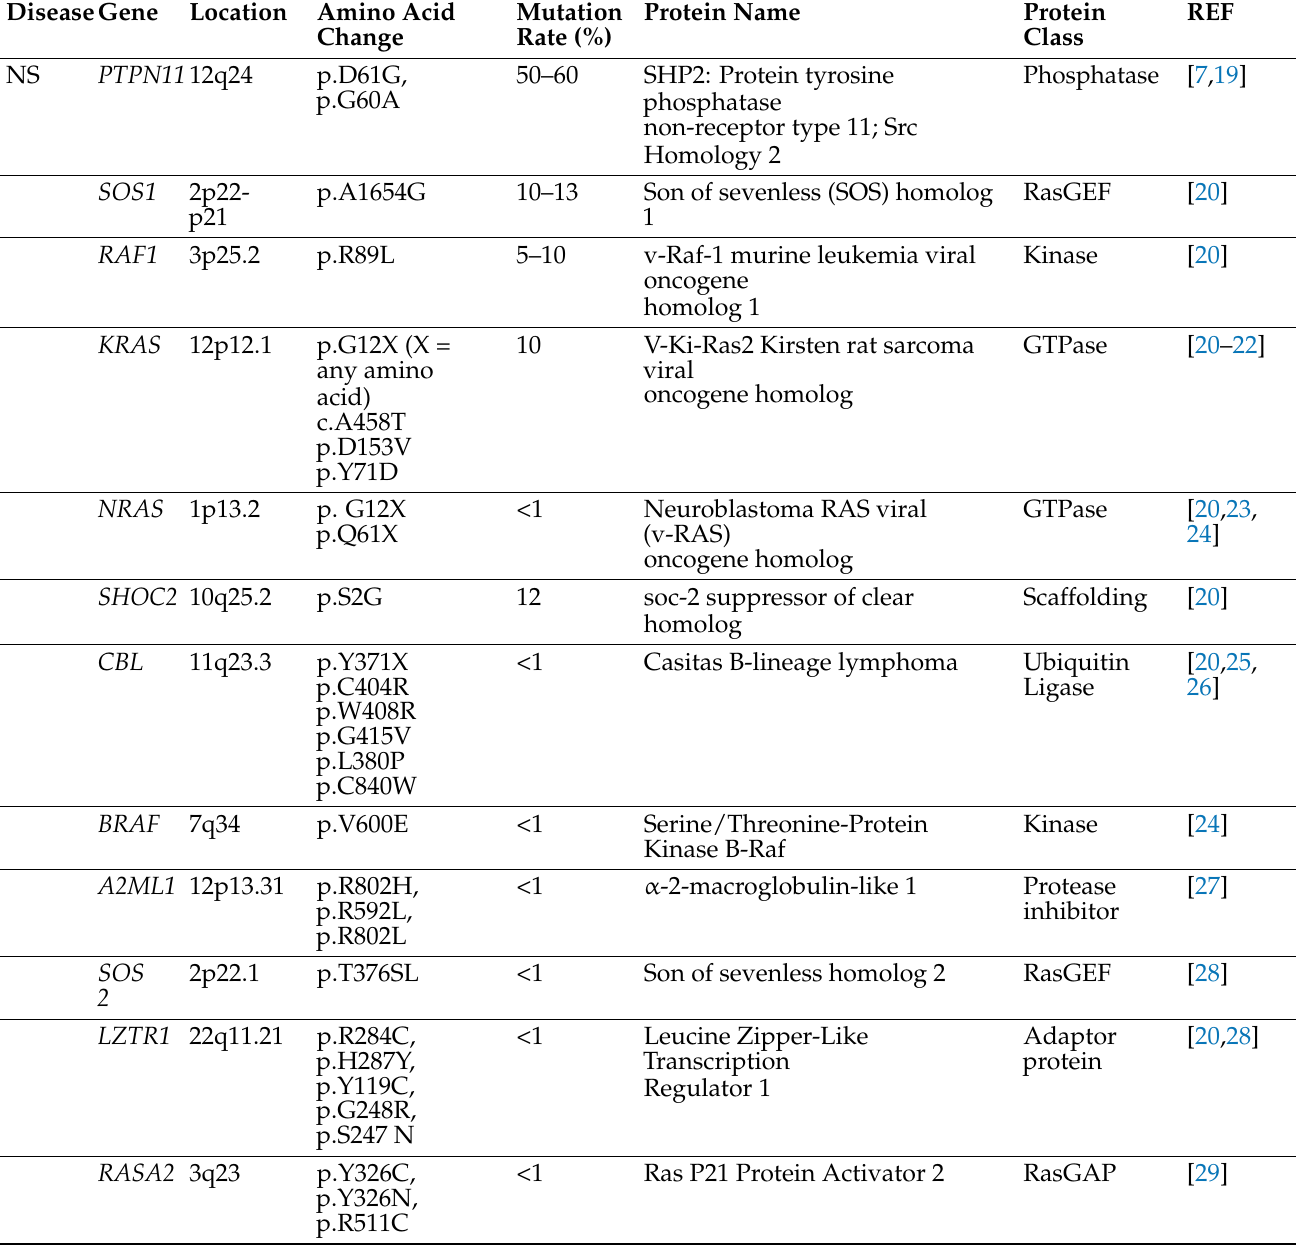
Table 1. Germline mutations of RAS/MAPK pathway responsible for NS and NSML